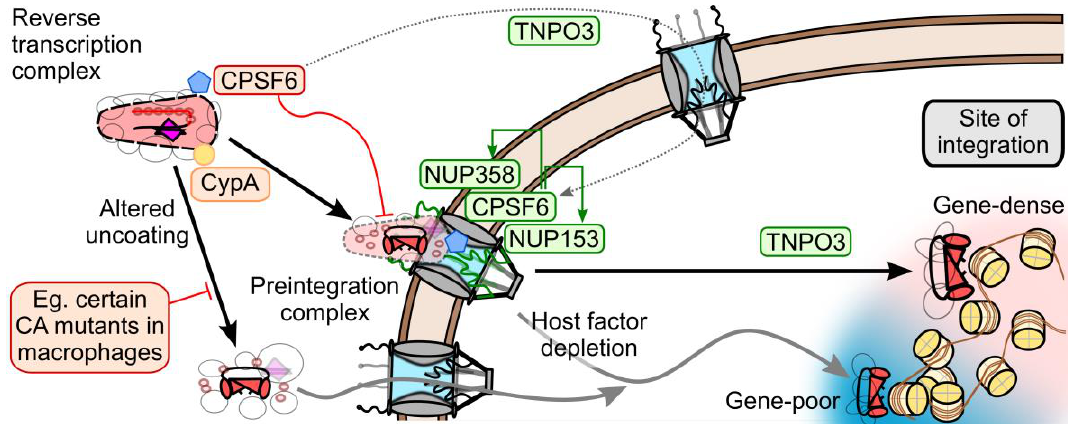
Figure 4. Model of the potential roles of the CA-dependent nuclear transport factors during HIV-1 infection. NUP358, NUP153, and CPSF6 at the nuclear pore most likely act on PIC-associated CA to aid HIV-1 infection. TNPO3 is required to localize CPSF6 to the nucleus; premature cytoplasmic CPSF6 binding to CA prevents nuclear import. TNPO3 may affect integration by interacting with IN within the nucleus. CypA modulates CA uncoating, altering dependencies on NUP358, NUP153, and TNPO3. Perturbation of this pathway by CA mutation or TNPO3, NUP153, or NUP358 knockdown results in altered integration site selection away from gene-dense regions of